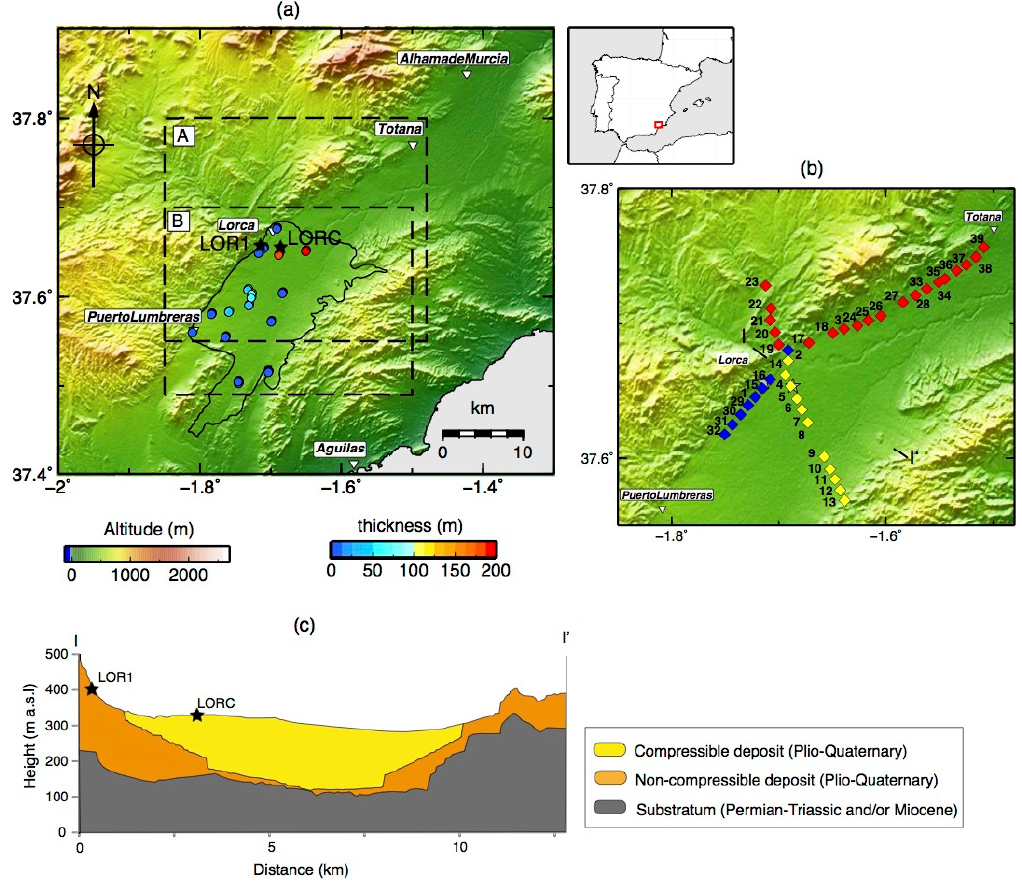
Figure 1. ( a ) Location map. The black-dashed rectangles labelled A and B outline the regions used for the interpolation of GPS vertical velocities and the thickness of compressible soils., respectively. The thickness of compressible deposits, formed by clay and silt layers, is shown as colored circles at 18 boreholes (estimated by [28]). The black line delimits the Alto Guadalentín aquifer. The SRTM-90 Digital Elevation Model was used to generate the background topography. Names for the main cities in the study area are indicated. ( b ) Location of the 39 points that we measured with GPS between 28 January and 1 March 2013. Each site is identified with a number from 1–39 (Supplementary Table A1). The height of these points had been previously measured by the Spanish National Geographic Institute (IGNE): red diamonds were measured in August–September 2004; yellow diamonds were measured in March 2005; and blue diamonds were measured in March 2009. ( c ) NW-SE geological cross-section of the Alto Guadalentín basin, from [28]. The location of the two permanent GPS stations, LOR1 and LORC, is indicated by the black stars in (a) and (c).